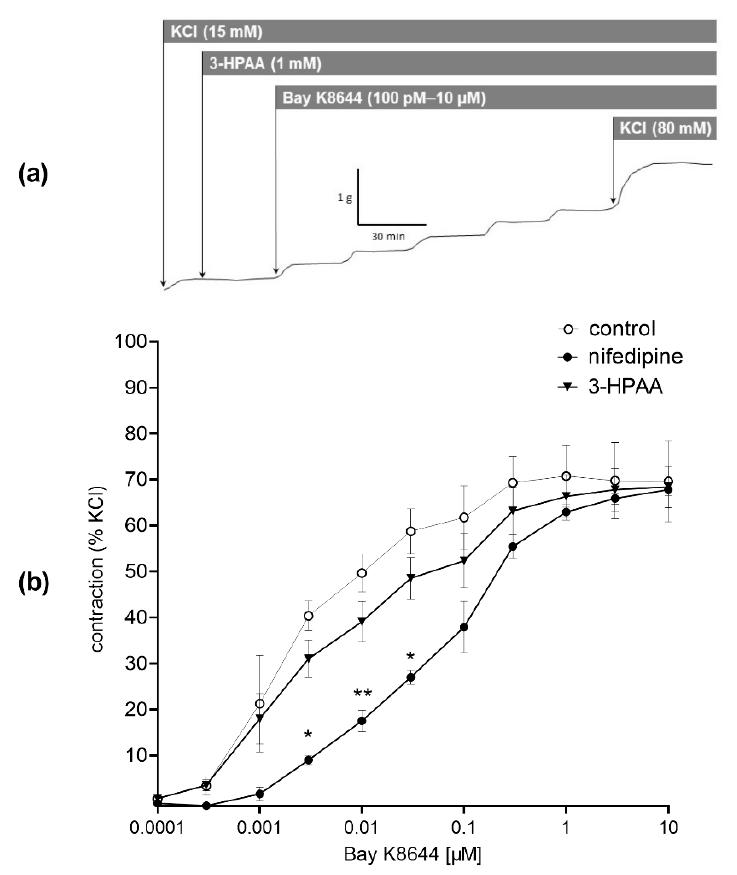
Figure 7. Scheme of the representative isometric tension traces of the porcine coronary arterial rings ( a ). Effect of pre-treatment of coronary rings with 3-hydroxyphenylacetic acid (3-HPAA, 1 mM) on contraction induced by cumulative doses of the L-type calcium channel activator, Bay K8644 (100 pM–10 µM). Nifedipine (150 nM) and vehicle (the Krebs solution) were used as positive and negative controls, respectively ( b ). Data were calculated from the maximal contraction induced by KCl (80 mM). Significant change: * p < 0.05, ** p < 0.01 vs. the control ( n = 7 for 3-HPAA, for both controls n = 4).